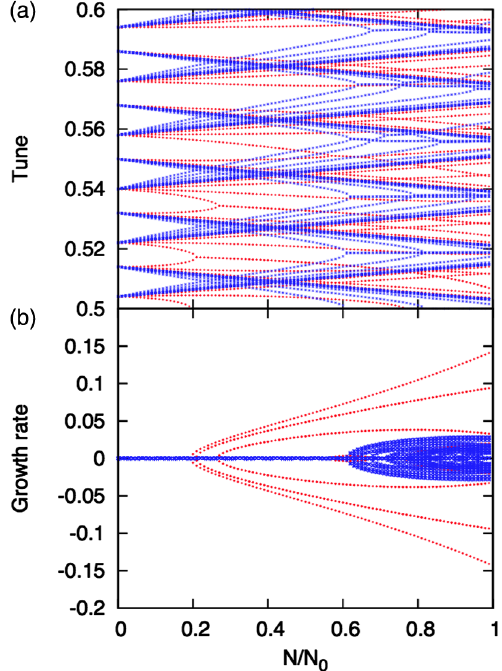
FIG. 17. Eigenvalues of the σ and π modes including the beam- = 2 ) as a function of the bunch population ( N ) beam tune shift ( ξ x for FCCee-Z. The tune and growth rate for scanning the bunch population N ð(cid:2)Þ ¼ 0 − N 0 are plotted in (a) and (b), respectively. The red and blue points represent the σ and π modes,